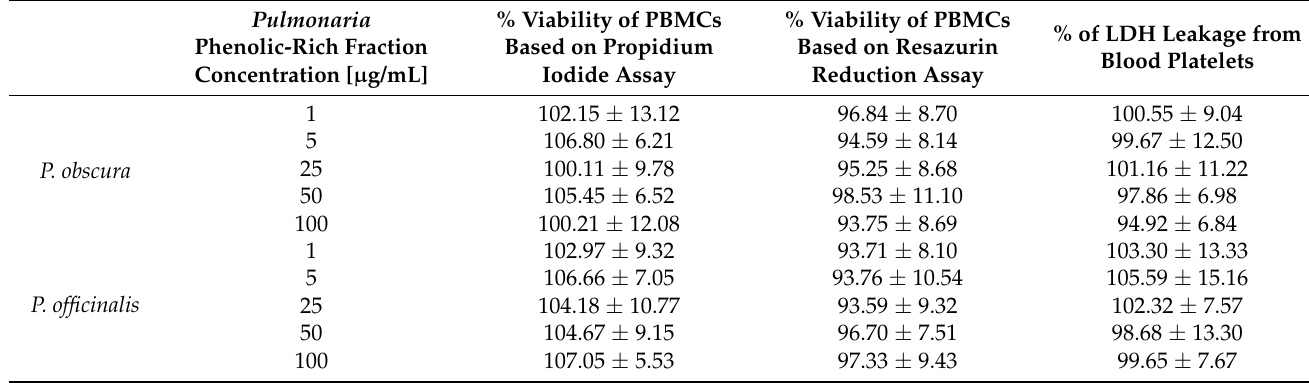
Table 7. Assessment of cytotoxicity of the examined Pulmonaria phenolic-rich fractions towards peripheral blood mononu- clear cells and blood platelets in vitro. Viability of control (untreated) PBMCs and LDH leakage in control blood platelets were assumed as 100%; ( n = 7–13; p >